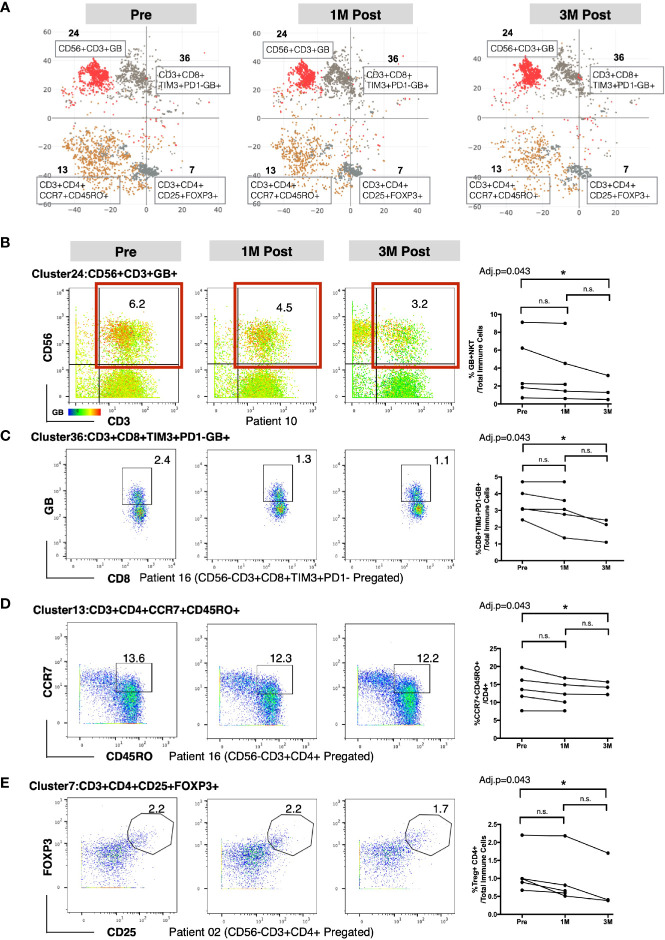
Altered frequencies in immune subsets in peripheral blood mononuclear cells (PBMCs) after Bacillus Calmette-Guerin (BCG) treatment. (A) t-SNE maps showing four clusters significantly different at three time points using repeated measure ANOVA test. (B) Left, representative dot plots for NKT cells (red boxed) colored by intensity of Granzyme B (GB) expression (cluster 24) from patient 10. Right, line plot showing the frequencies of GB+NKT cells over total immune cells at three time points from all patients. (C) Left, representative dot plots for GB expressing PD-1-TIM3+CD8+ T cells (cluster 36) from patient 16. Right, line plot showing the frequencies of GB+PD-1-TIM3+CD8+ T cells over total immune cells at three time points from all patients. (D) Left, representative dot plots for central memory CD4+ T cells from patient 16. Right, line plot showing the frequencies of CD4+CCR7+CD45RO+ T cells (cluster 13) over CD4+ T cells at three time points from all patients. (E) Left, representative dot plots for Treg cells (cluster 7) from patient 02. Right, line plot showing the frequencies of Treg cells over total immune cells at three time points from all patients. B–E, connected line specifies samples from same patient at different time points. *adjusted p<0.05 or not significant (n.s.) by non-parametric One-way ANOVA by Friedman’s test followed by Dunn’s post-test for matched data points with complete set of three time points.